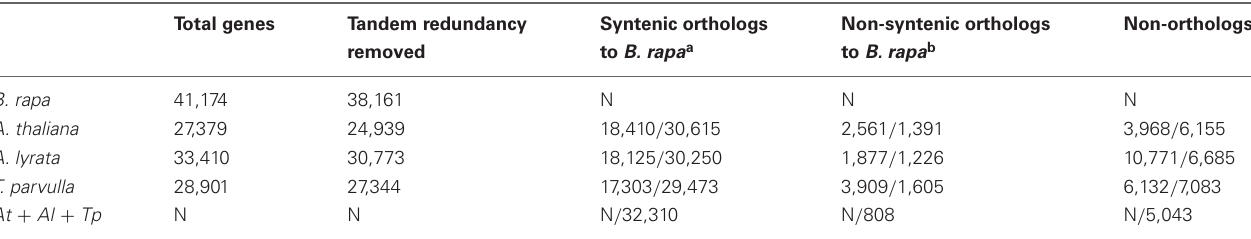
Table 1 | The homologous relationships of genes between B. rapa and A. thaliana , A. lyrata , or T. parvulla .